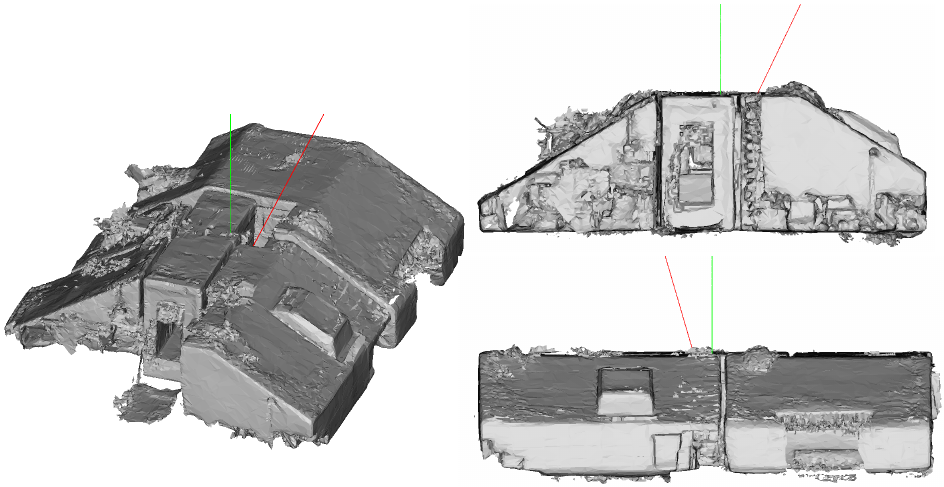
Figure 7. Exemplary triangle mesh of a building with a partially slanted ceiling (dataset “Attic” from [31]). The green line visualizes the reference orientation of the vertical axis considered as the ground truth, while the red line visualizes the vertical axis rotated by − 25° around the horizontal (cid:126) x axis and by 15° around the horizontal (cid:126) y axis, as exemplarily used in Section